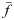
Sweep pitch shift.A) Kernel density estimations on the perceived pitch are plotted separately for each of the 30 FM-sweeps used in experiment 1; each of the three panels displays the data of each of the three average frequencies f‾. Data points correspond to the average sweep pitch shift Δ=fperceived−f‾ (y-axis) of a target sweep with a specific frequency span Δf (x-axis) reported by one participant. Red crosses show the mean and standard error of the average Δp across participants. Dark dashed lines show the linear fit of the average Δp across participants. B) Kernel density estimations of the subjects’ standard deviation of the sweep pitch shift Δp, plotted separately for the different frequency spans Δf. Each sample in the distributions corresponds to the standard deviation of the perceived pitch of a sweep in one subject (i.e., in each distribution there are 8 × 3 points, one for each subject and f‾). The standard deviation is monotonically correlated to the absolute span |Δf| (Pearson’s r = 0.48, p < 10−14). C) Kernel density estimations of the up/down asymmetry asymm↑↓ distributions as defined in Eq (1). Each sample of the distributions corresponds to the difference of the average absolute deviation from centre frequency between up and down sweeps of the same |Δf| for a given subject and centre frequency (N = 8 × 3 = 24). Red crosses show the mean and the standard error of the data.